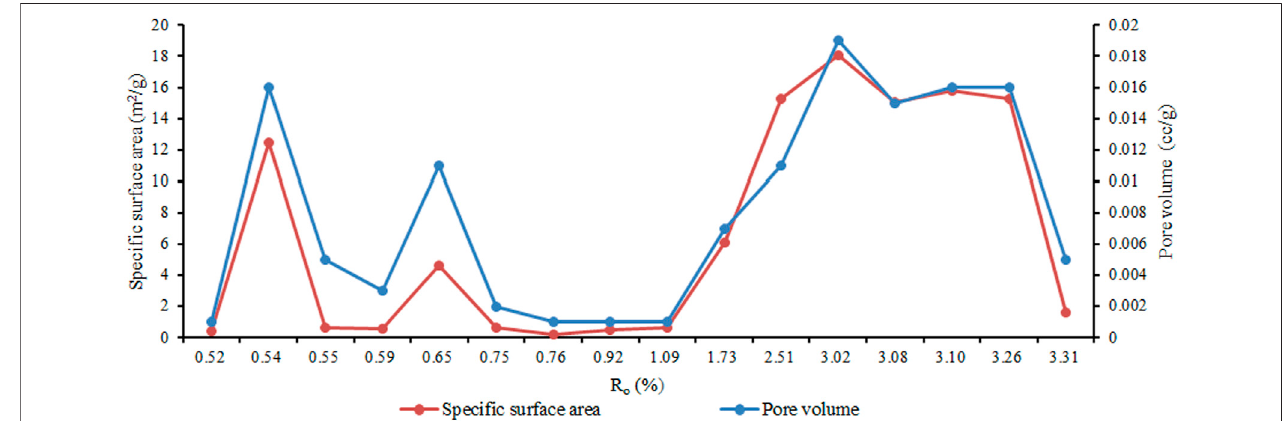
FIGURE 8 | Changes of pore volume and speci fi c surface area of shale samples under different maturity conditions.